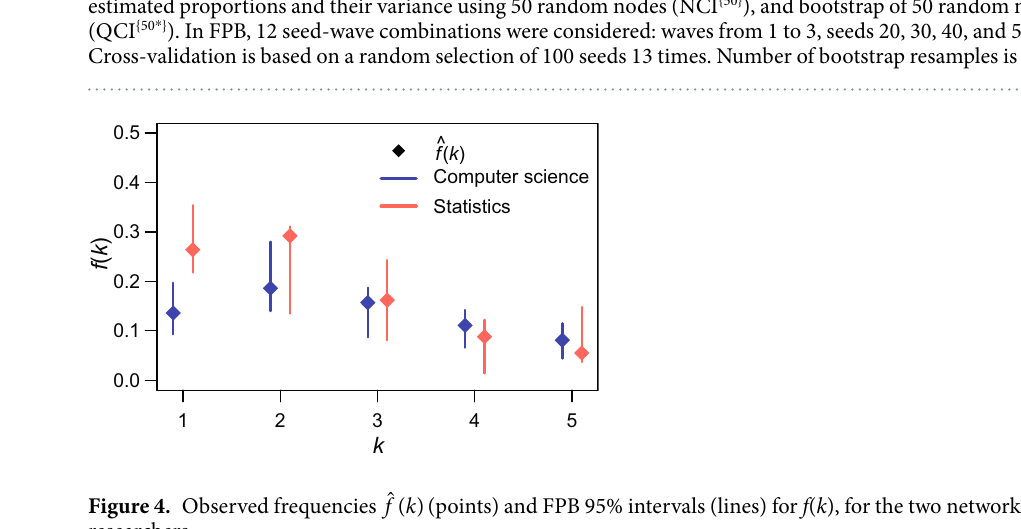
Figure 4. Observed frequencies ˆ f k ( ) (points) and FPB 95% intervals (lines) for f ( k ), for the two networks of